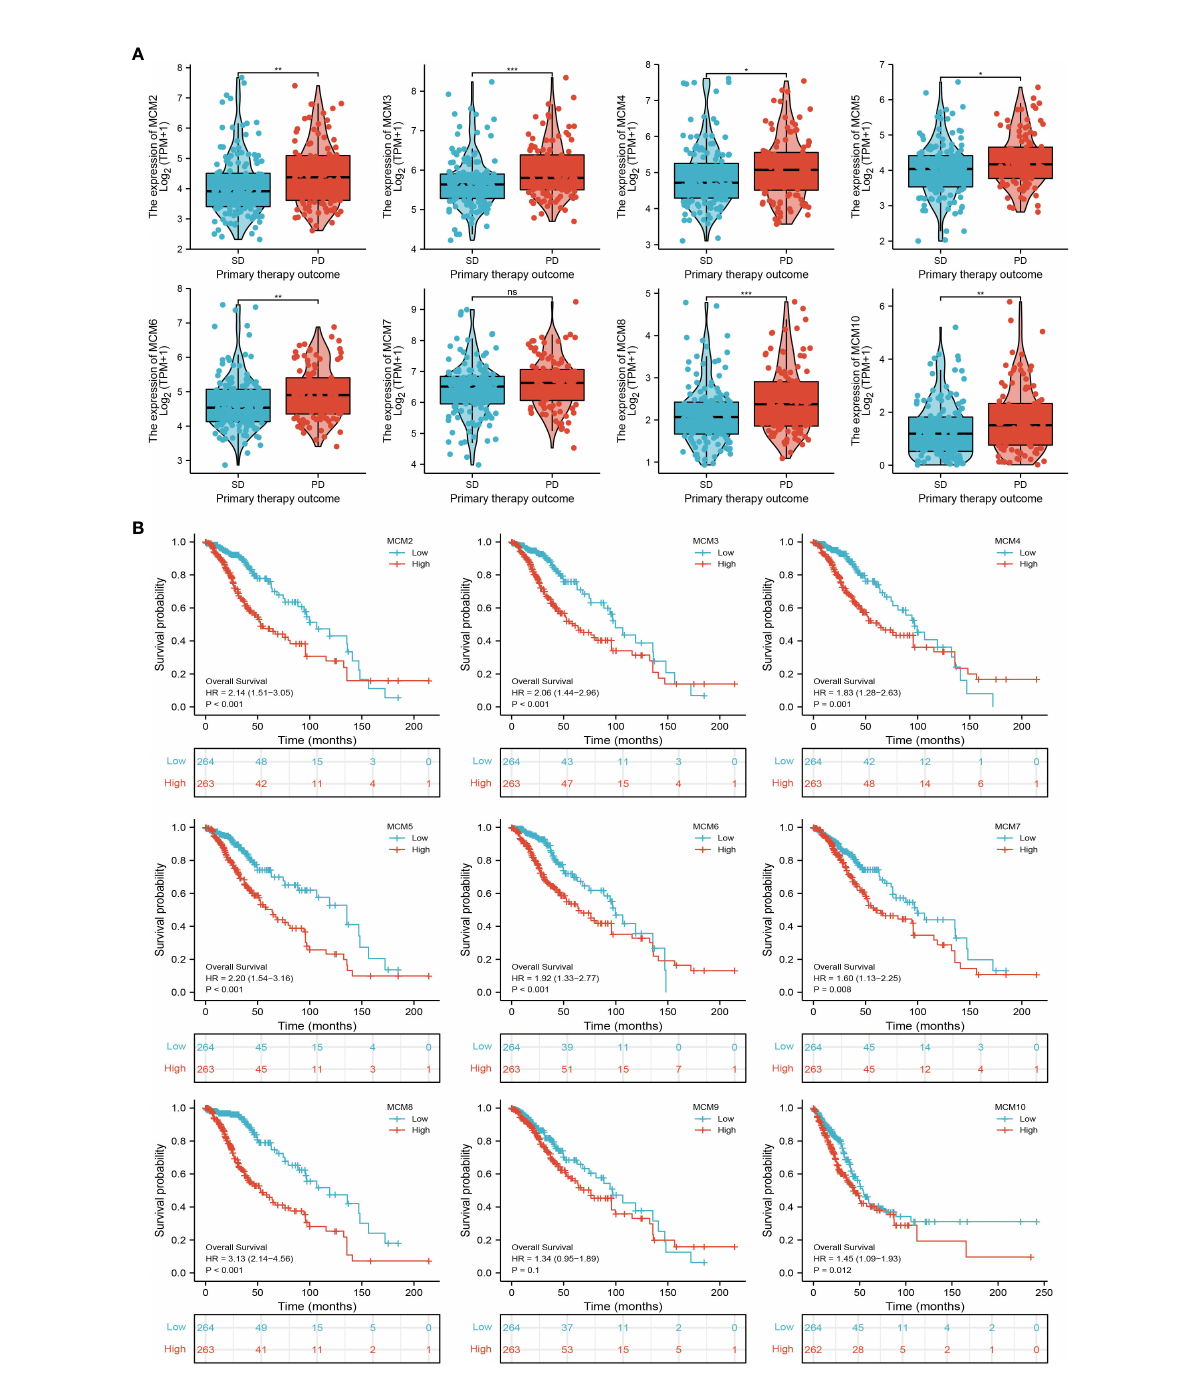
FIGURE 4 The correlation between MCMs expression and clinical information in glioma. (A) The correlation between MCMs expression and clinical features, including the 1p/19q codeletion and histological type in glioma based on TCGA-glioma. (B) The overall survival (OS) of MCMS in glioma was examined by the TCGA database. PD, progressive disease; SD, stable disease; NS: p >0.05, *p < 0.05, **p < 0.01, ***p <